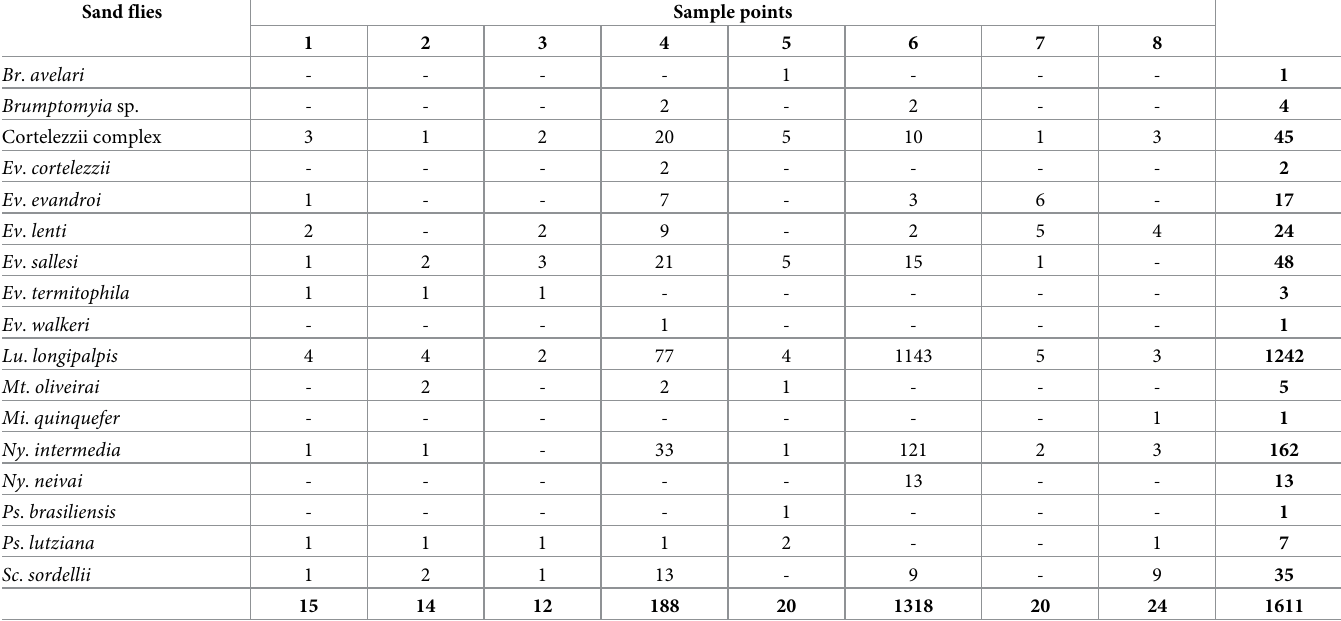
Table 2. Sand flies collected in Lassance, Minas Gerais, Brazil from May 2018 to April 2019. Sand flies Sample points